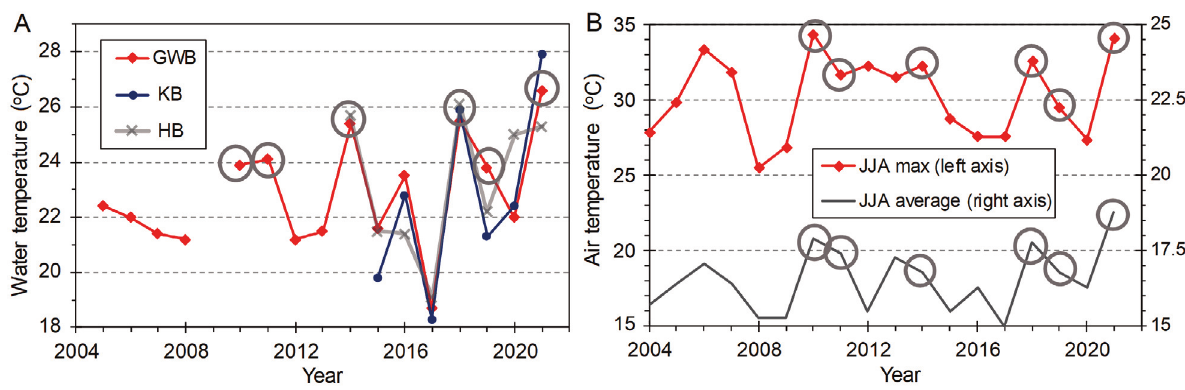
Fig. 3. A , summer SST maxima in the Gulf of Finland at the Gulf of Finland wave Buoy (GWB), Kotka Kuusenkari buoy (KB) and Hanko Längden buoy (HB) in 2005–2021. B , summer (June, July, August – JJA) maximum and average air temperatures at the Kunda station in 2004–2021. The selected years for further analysis of HW/MHW events are